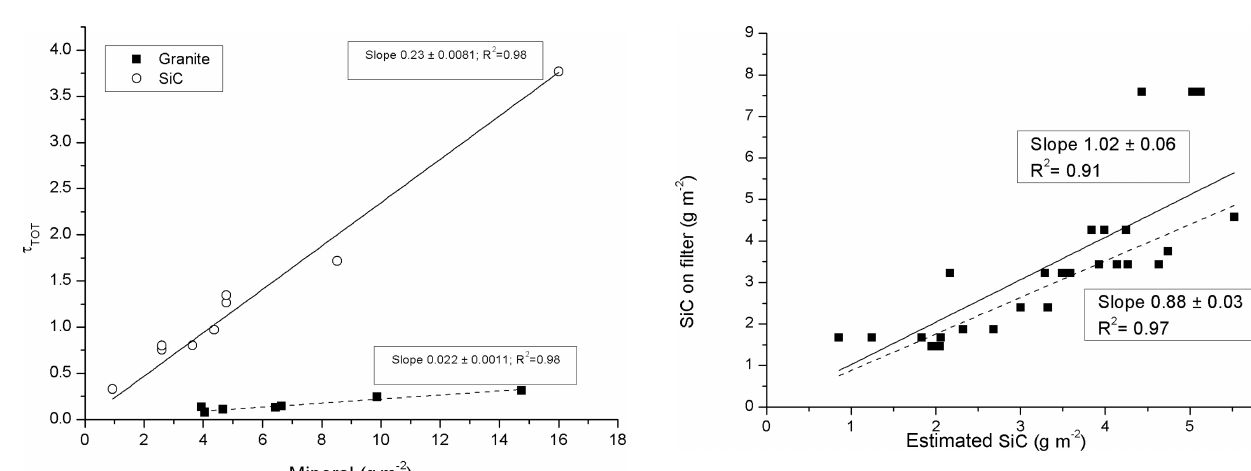
Figure 6. Comparison between the weighed SiC amounts added to the water and the optically derived SiC density on the substrate. The data is for Chimney soot and SiC mixtures, with two alterna- tive slopes; one containing all data points (1.02), and one excluding three data points in the top right of graph